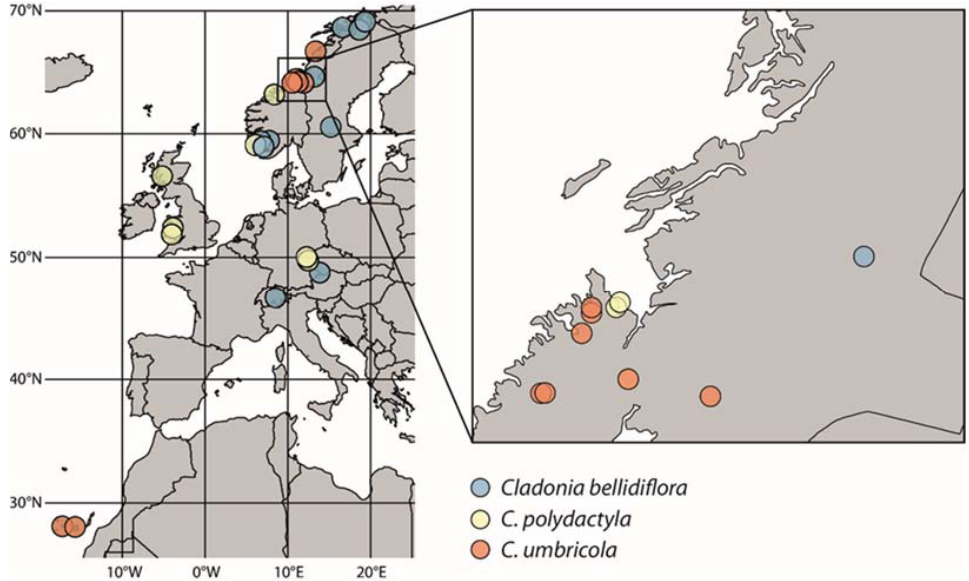
Figure 2. Geographic location of collections used in the main dataset.